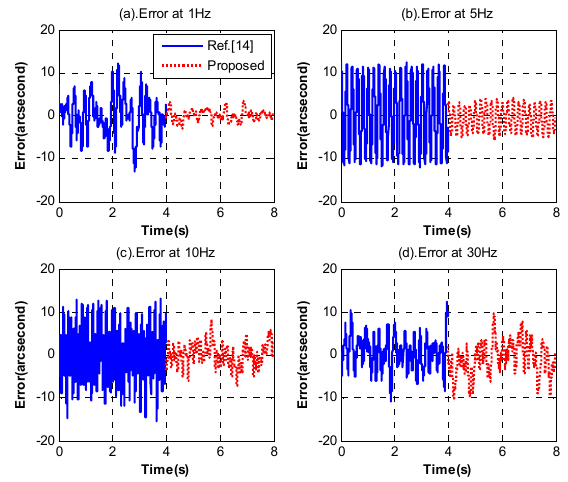
Figure 15. The residual stabilization errors in different frequencies.